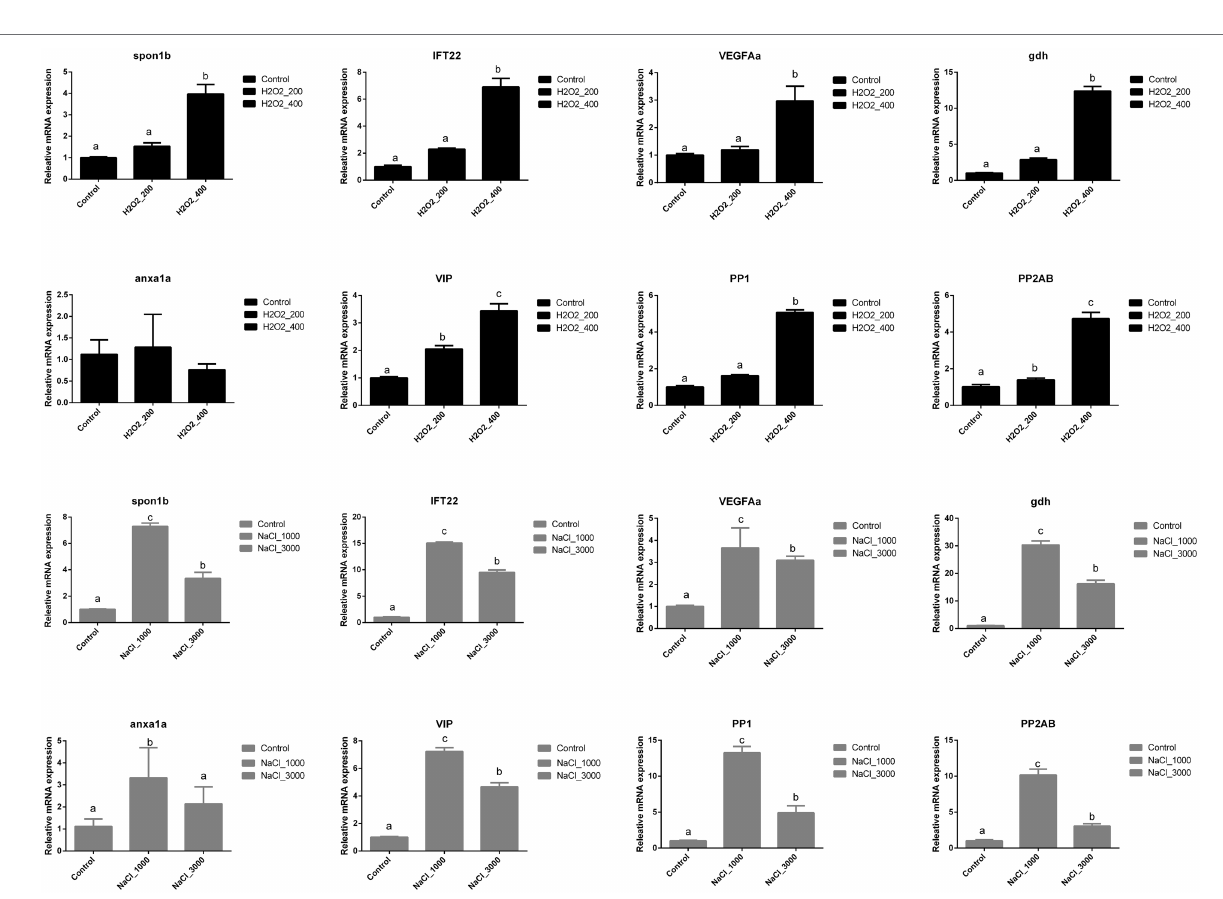
FIGURE 2 | Effects of H 2 O 2 (200, 400 mg/ml) and NaCl (1,000, 3,000 mg/ml) pre-treatment during egg hatching on the relative expression levels of genes involving early development including spon1b, IFT22, VEGFAa, gdh, anxa1a, VIP, PP1, and PP2AB in loach